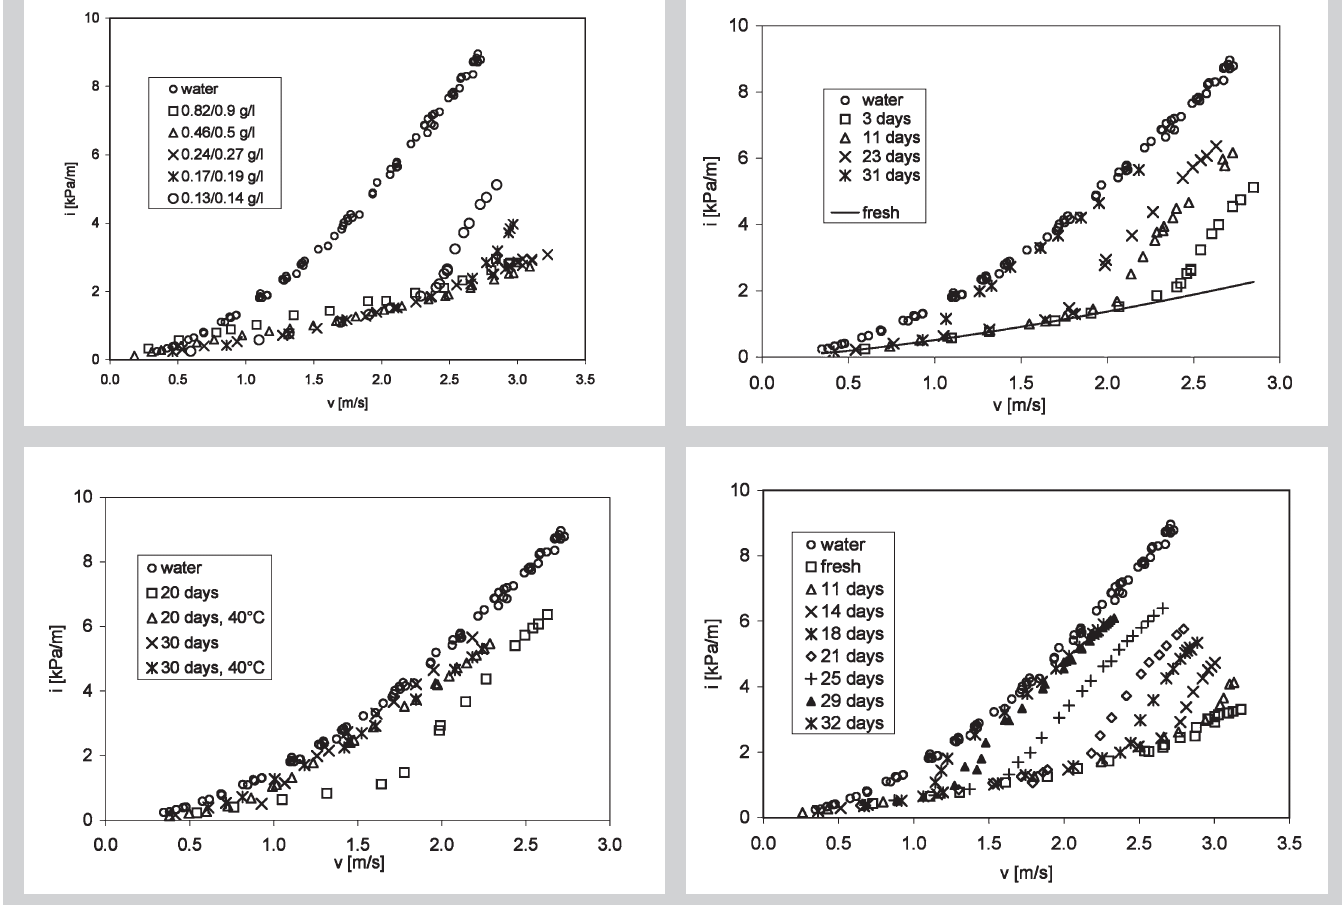
Figure 3 (left above): Dependence of pressure drop on mean velocity in solutions 2 to 4 days old with concen- trations in g/l 0.82/0.9; 0.46/0.5; 0.24/0.27. In solu- tions with lowest concentra- tions 0.17/0.19 g/l starts the time degradation already at 5 days and with 0.13/0.14 g/l at 3 days. Figure 4 (right above): Shown is the process of degra- dation of the surfactant with age. The full curve is averaged i - v dependence of the fresh solutions with best drag reduction achieved in these experiments. Figure 5 (left below): Influence of heating from 20xxxC to 40xxxC of the 20 days old 0.13/0.14 g/l solution and of the same 30 days old solution. Drag reduction is completely lost after 30 days but it gains a little by heating. Figure 6 (right below): Degradation of the CTAB/NaSal = 0.22/0.25 g/l solution by